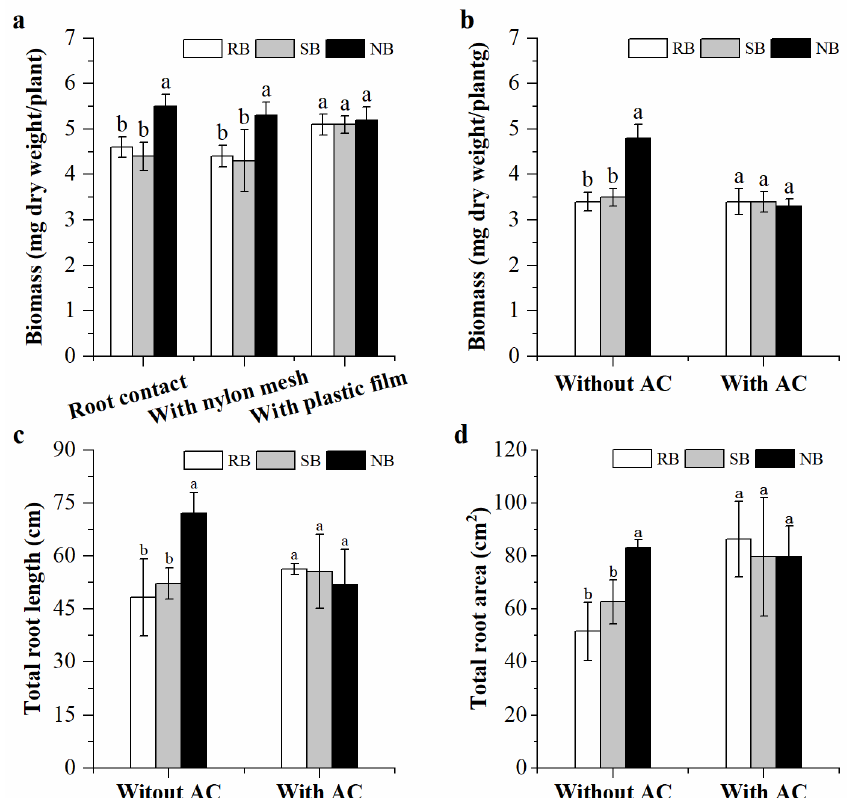
Figure 3. The effects of root segregation and soil activated carbon ( AC ) amendment on root kin recognition responses of penoxsulam-resistant barnyardgrass ( RB ) in the presence of penoxsulam- susceptible barnyardgrass ( SB ) and normal barnyardgrass ( NB ). ( a ), Root biomass under root seg- regation; ( b ), Root biomass with and without soil activated carbon amendment; ( c ), Total root length with and without soil activated carbon amendment; ( d ), Total root area with and without soil activated carbon amendment. Values plotted are means plus/minus SE. Columns with the same letter within identical treatments are not significantly different at p < 0.05 according to ANOVA, followed by Tukey HSD tests.